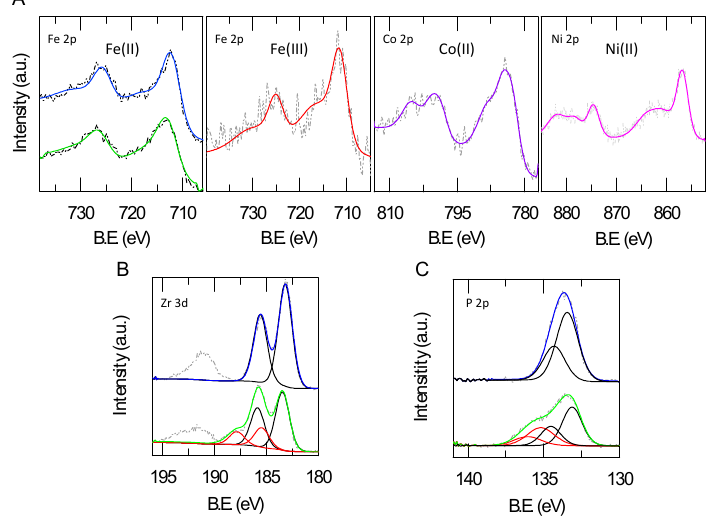
Figure 6. ( A ) XPS spectra for Fe(II), Fe(III), Co(II), and Ni(II) ZrP systems. Blue and green curves in Fe(II) panel represent the 10:1 M:ZrP intercalated and adsorbed systems, respectively, while intercalated 10:1 M:ZrP systems are represented in the Fe(III), Co(II), and Ni(II) panels. ( B ) XPS spectra for Zr 3d and ( C ) P 2p where blue and green curves represent intercalated and adsorbed systems, respectively, from 10:1 Fe(II):ZrP.